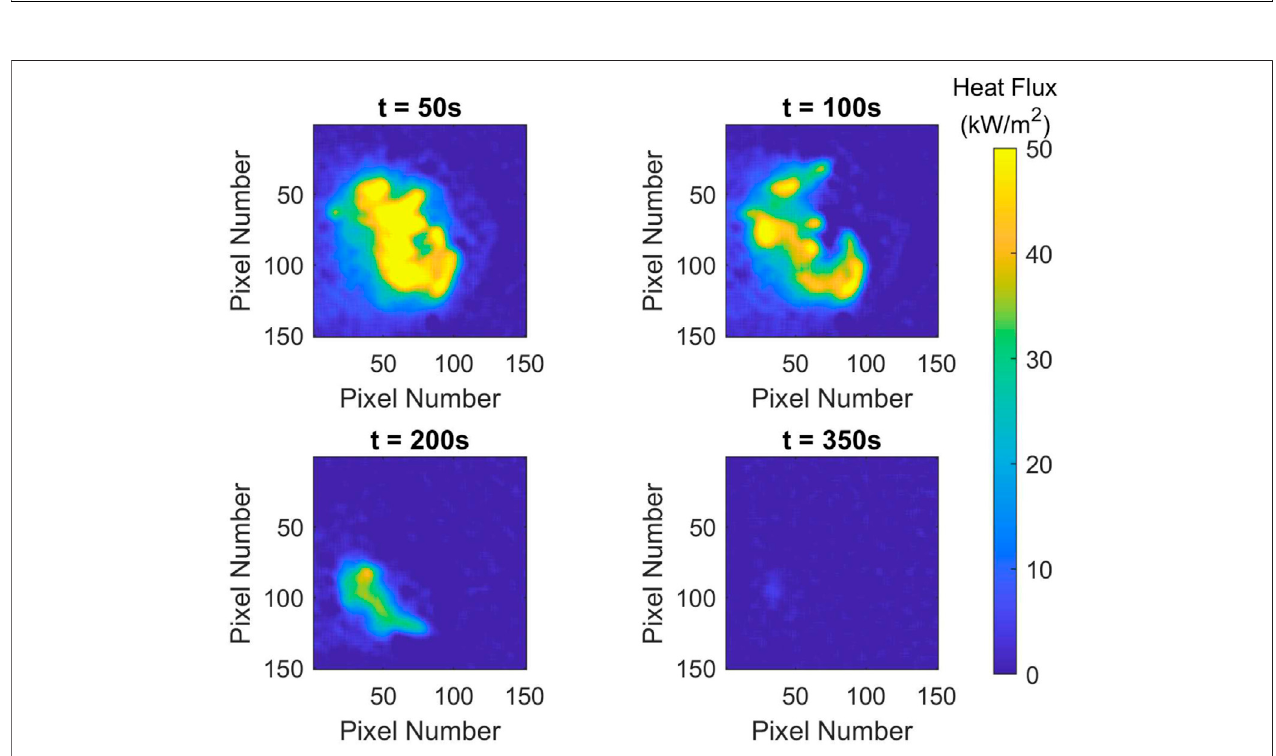
FIGURE 12 | Heat fl ux distribution for test FF10 at different times. Firebrands: D (cid:2) 4.75 mm, L (cid:2) 50.0 mm, and AR (cid:2) 10.5; Pile mass of m (cid:2) 1.5 g; Wind speed: U (cid:2) 2.0 m/s.